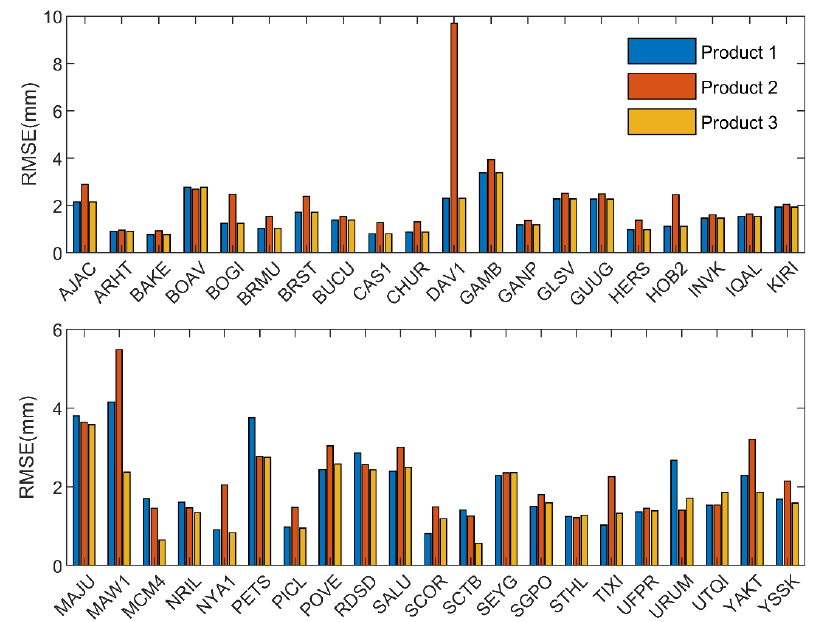
Figure 7. RMSE of the PWVs converted from PPP-ZWDs during 154 days in 2020 at each of the 41 IGS stations resulting from three VMF forecasting products.